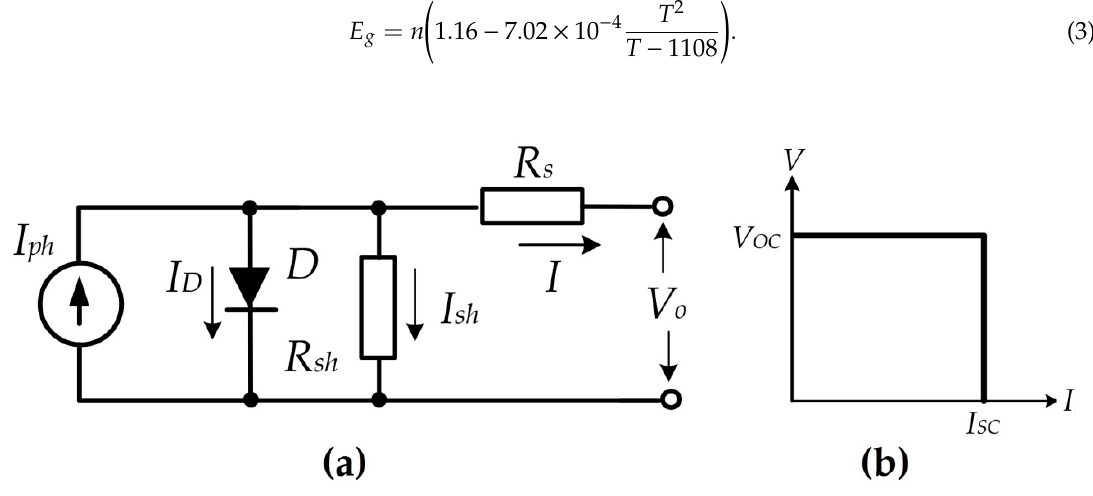
Figure 2. ( a ) The single-diode equivalent circuit of the photovoltaic cell ( I ph is photocurrent, D is diode, I D is diode current, R sh is shunt resistance, I sh is shunt current, R S is series resistance, I is output current, and V 0 is output voltage). ( b ) The V–I characteristics correspond to the simplified equivalent circuit of the solar module ( V OC is open-circuit voltage, I SC is short-circuit current).